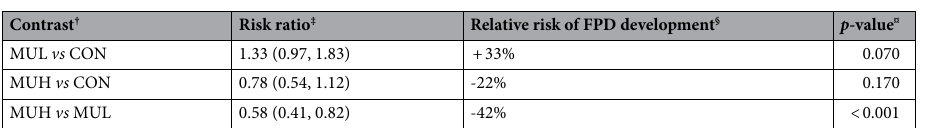
Table 3. FPD risk ratio computation on 2 by 2 tables aligning the combinations of levels of the factor group and putting binarily aggregated FPD scores in columns. † The inverse contrasts produce a risk ratio equals to the reciprocal of the risk ratio shown. ‡ 95% Wald confidence interval is given in brackets. § Calculated as risk ratio minus 1 percentagewise. ¤ Count data were statistically analyzed via Pearson’s chi-square